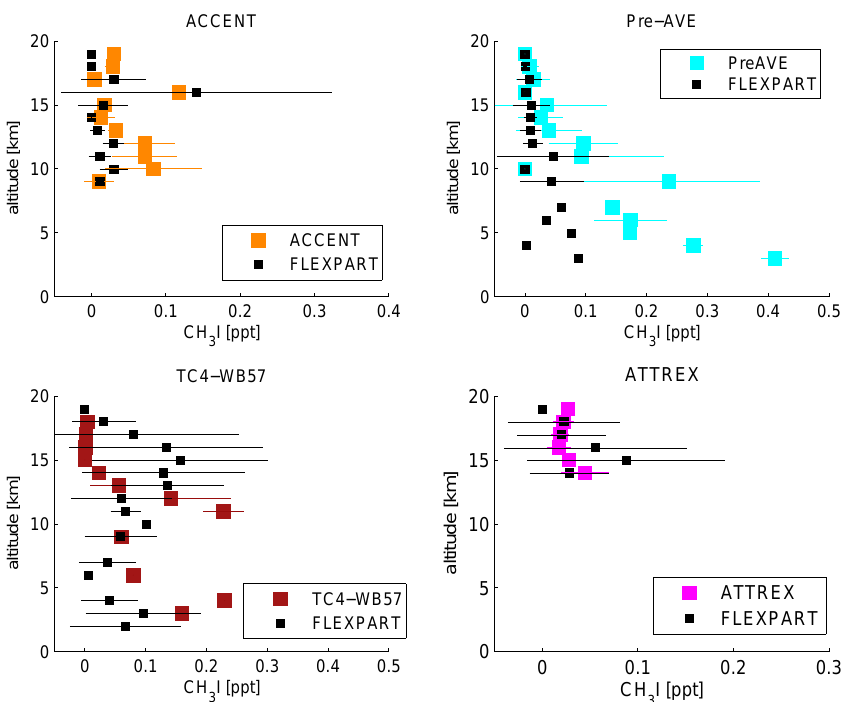
Fig. 8. Same as Fig. 7 for vertical profiles of CH 3 I in the troposphere and TTL for the aircraft campaigns ACCENT, Pre-AVE, TC4-WB57, and